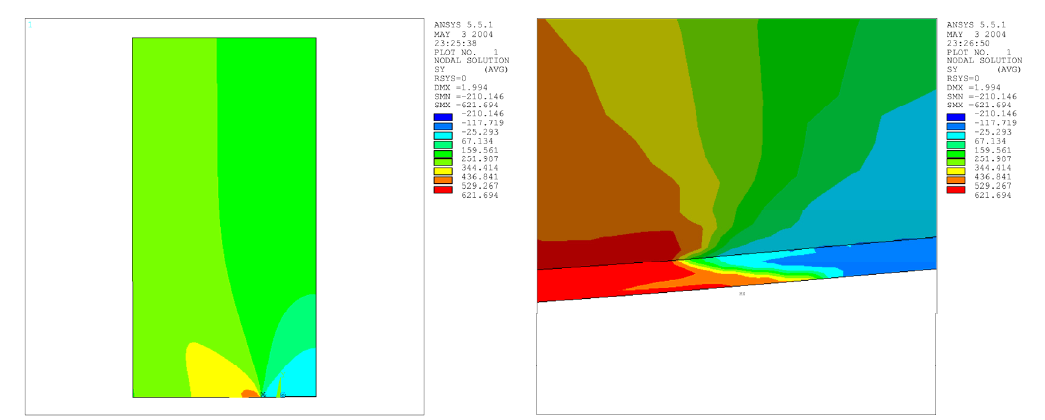
Figure 11: Calculated stress distribution in the traction direction (y) for  a = 25 mm.